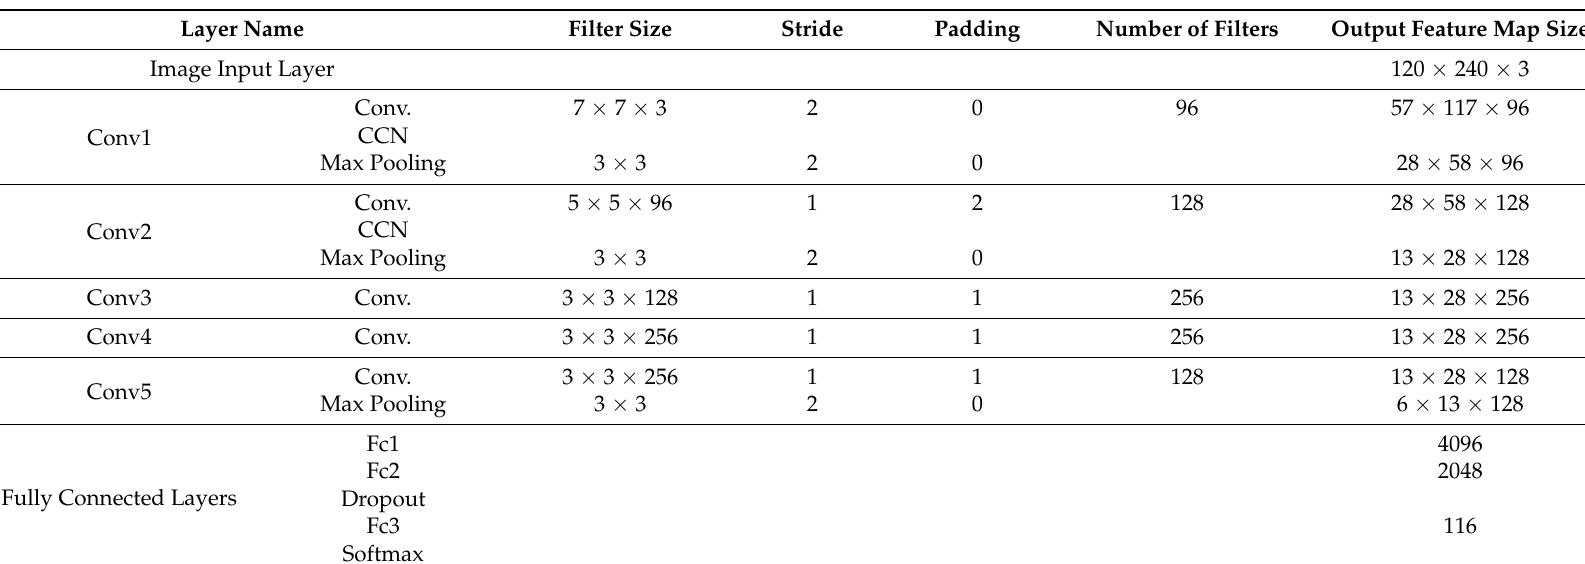
Table 3. Architecture of AlexNet used in this study (unit: